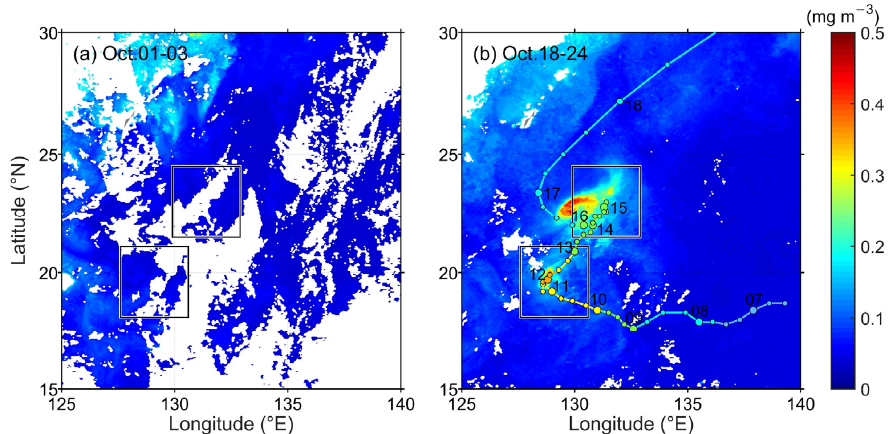
Figure 4. Spatial distribution of the chlorophyll-a (Chl-a) concentration before and after the passage of Typhoon Prapiroon. ( a ) The pre-typhoon Chl-a concentration, averaged on 1–3 October; and ( b ) the Chl-a concentration after Prapiroon, averaged on 18–24 October. Two solid boxes are the two focused domains of the sudden-turning stages of the typhoon, denoted A1 and A2. The coloured lines and dots represent the track and intensity of the typhoon.